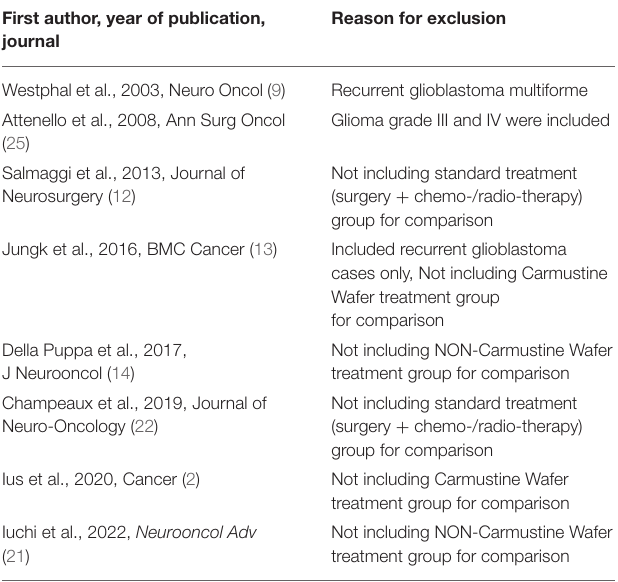
TABLE 1 | Studies excluded from the